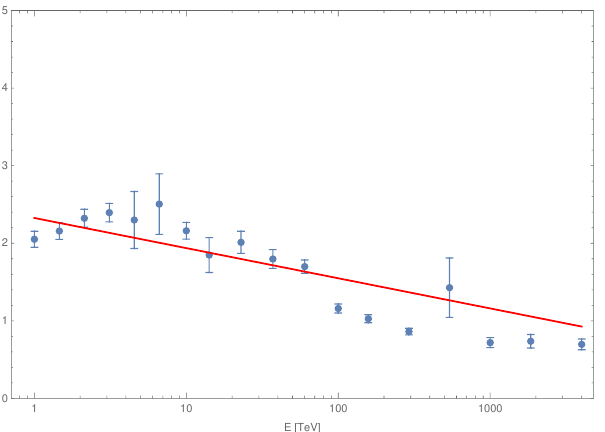
Figure A5. Values of Gaussian distribution parameter σ (for electrons) for different energies of the vertical cascades and protons as the primary cosmic-ray